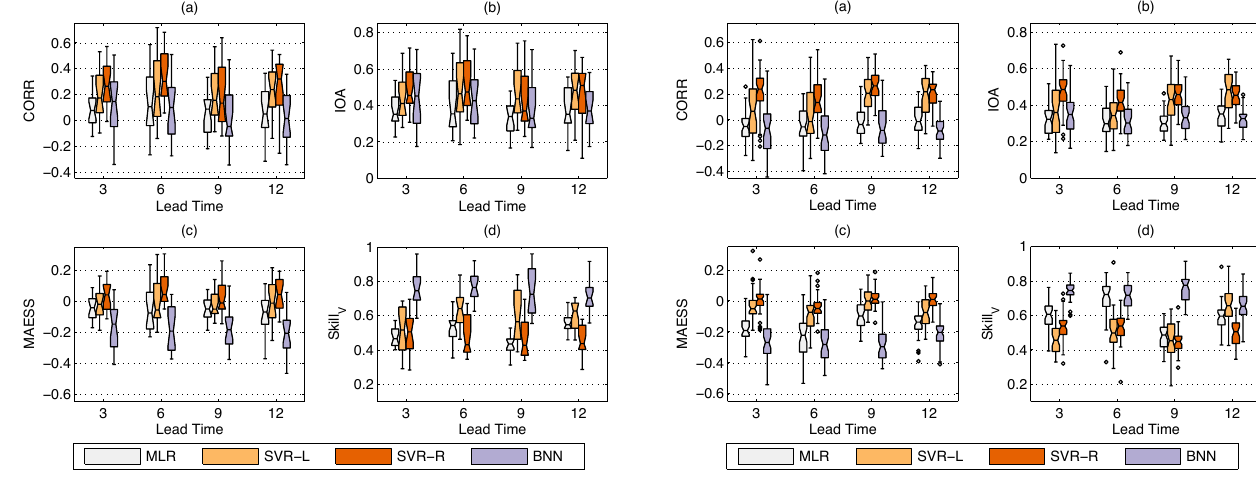
Fig. 2. Cross-validated forecast scores, (a) CORR, (b) IOA, (c) MAESS and (d) Skill V , in the Pacific coastal region (region R1) for the winter extreme precipitation at lead times of 3, 6, 9 and 12months using the MLR, SVR with linear kernel (SVR-L), non- linear SVR with RBF kernel (SVR-R) and BNN models. Lead time of 3months means that predictor data up till September–November were used to forecast the December–February extreme precipita- tion. The “waistline” of the boxplot shows the median of all the val- ues in the region R1, while the 25th and 75th percentiles are shown, respectively, as the bottom and top of each box. Distance between the 25th and 75th percentiles is the interquartile range (IQR). Data points more than 1.5 IQR from the median are considered outliers, and are shown as small circles (none in this figure). The whiskers indicate the data point nearest but not exceeding 1.5 IQR from the median.